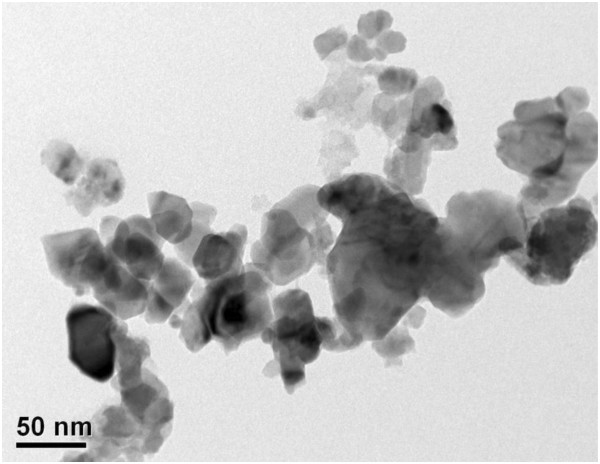
TEM image of the CdSe-C60/TiO2 compounds.